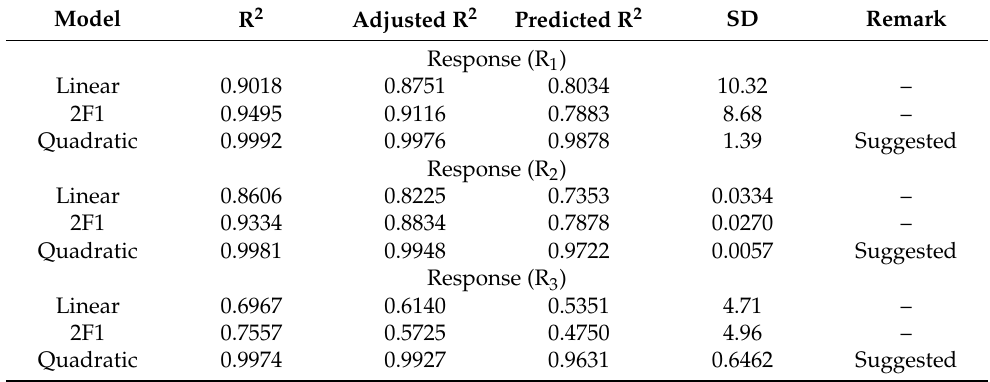
Table 3. Statistical summary of the applied model of 3 3 -BBD on R 1 (PS), R 2 (PDI), and R 3 (%EE).